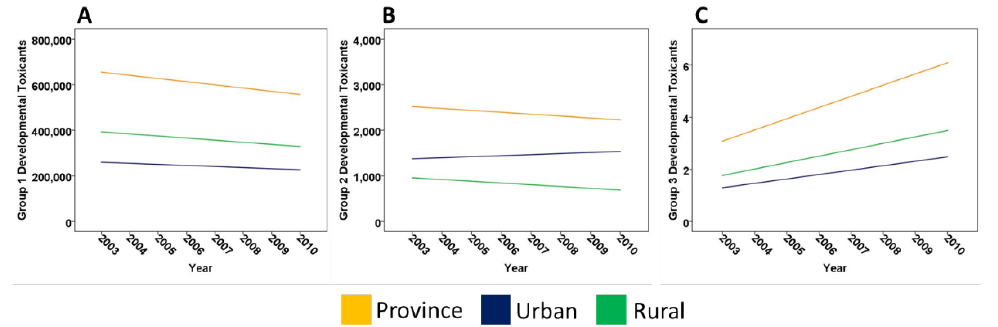
Figure 2. Developmental toxicants in amounts (tonnes). ( A ) Group 1 DTs demonstrated a decreasing trend in the province, (* p = 0.004); ( B ) There was no statistically significant decrease in Group 2 emissions in the province and its urban and rural regions; ( C ) Group 3 DTs showed a statistically significant increase in the province overall, (* p < 0.001). DT = developmental toxicant, * p value ≤ 0.004 = significant post Bonferroni adjustment.